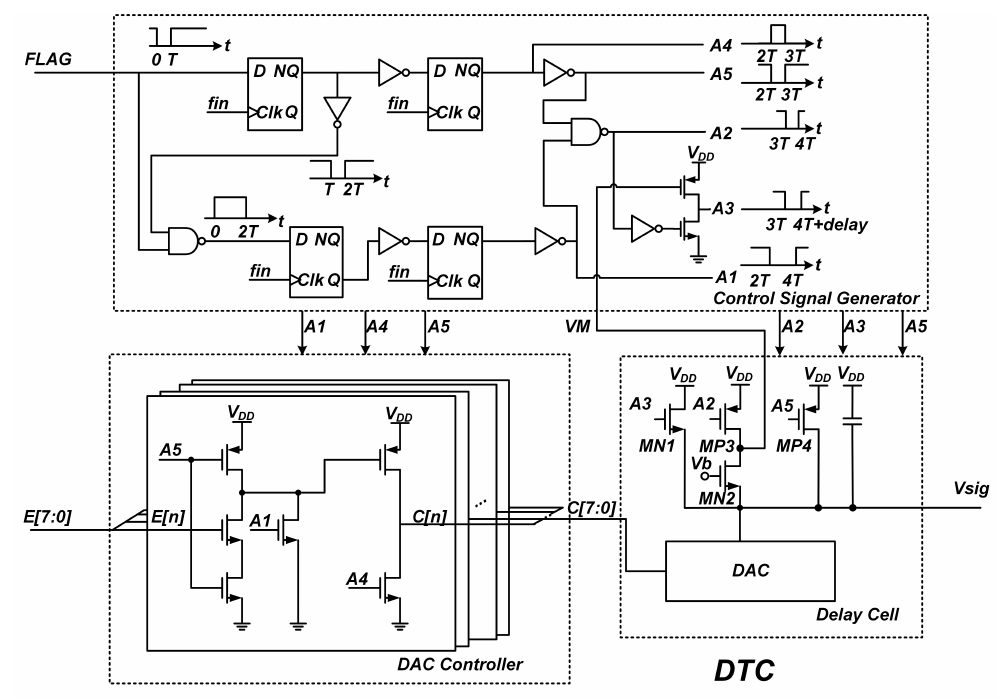
Figure 6. Diagram of the proposed DTC